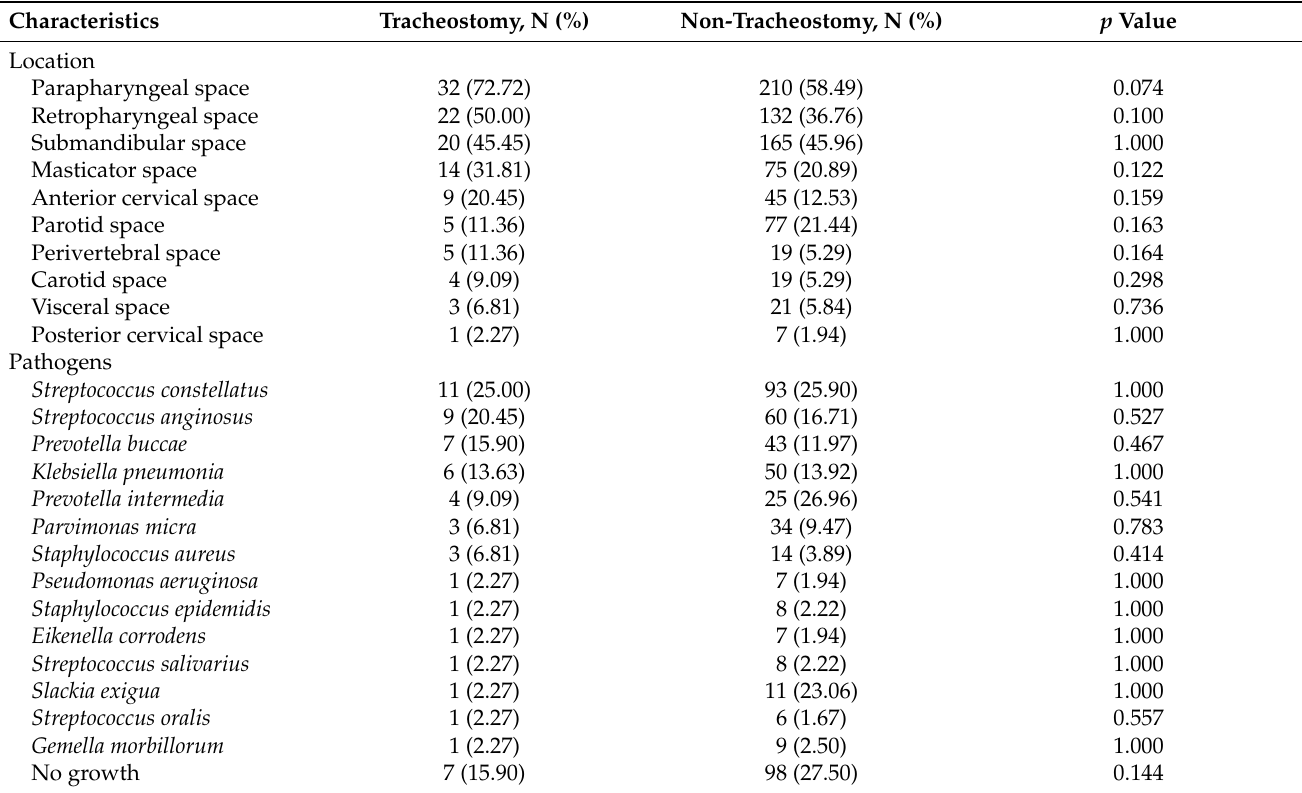
Table 3. Comparison of involved spaces and pathogens between 44 patients with tracheostomy and 359 patients without tracheostomy in deep neck